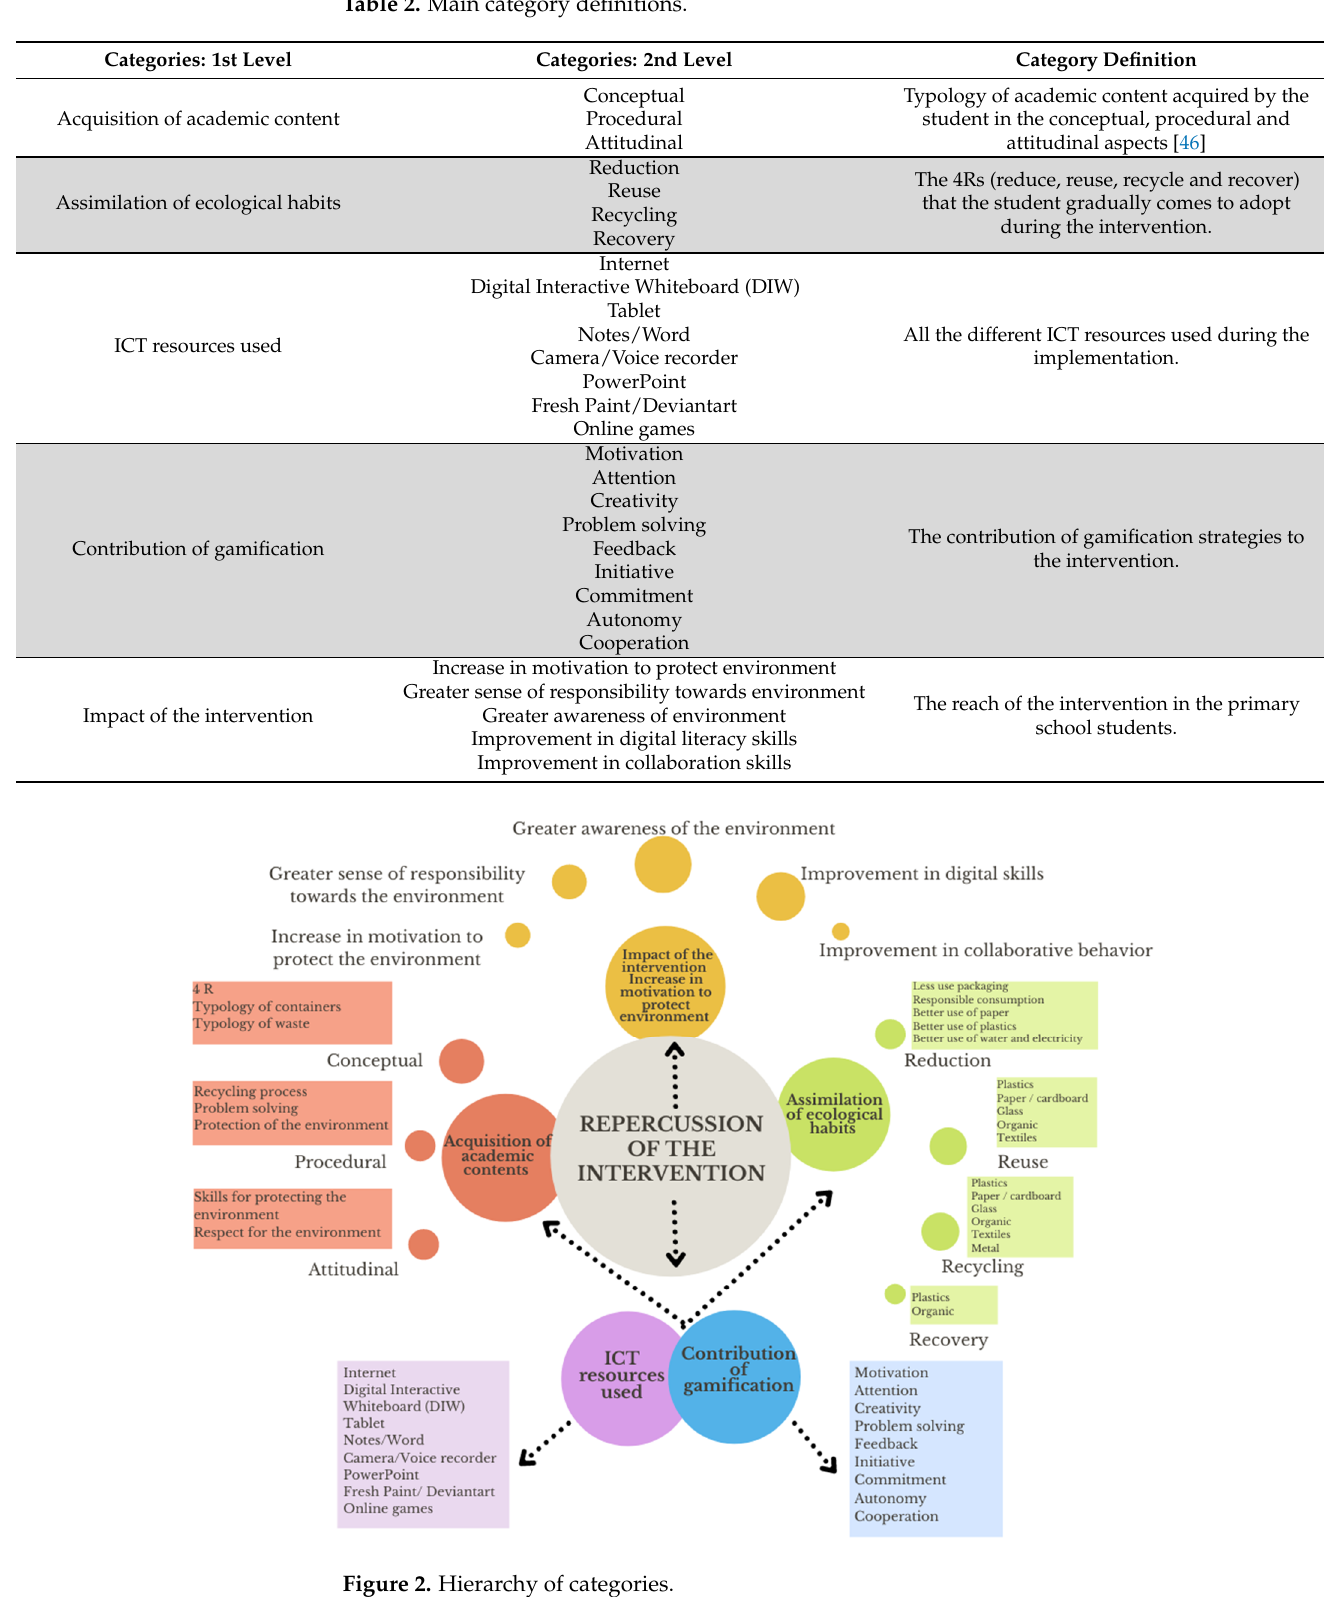
Table 2. Main category definitions.